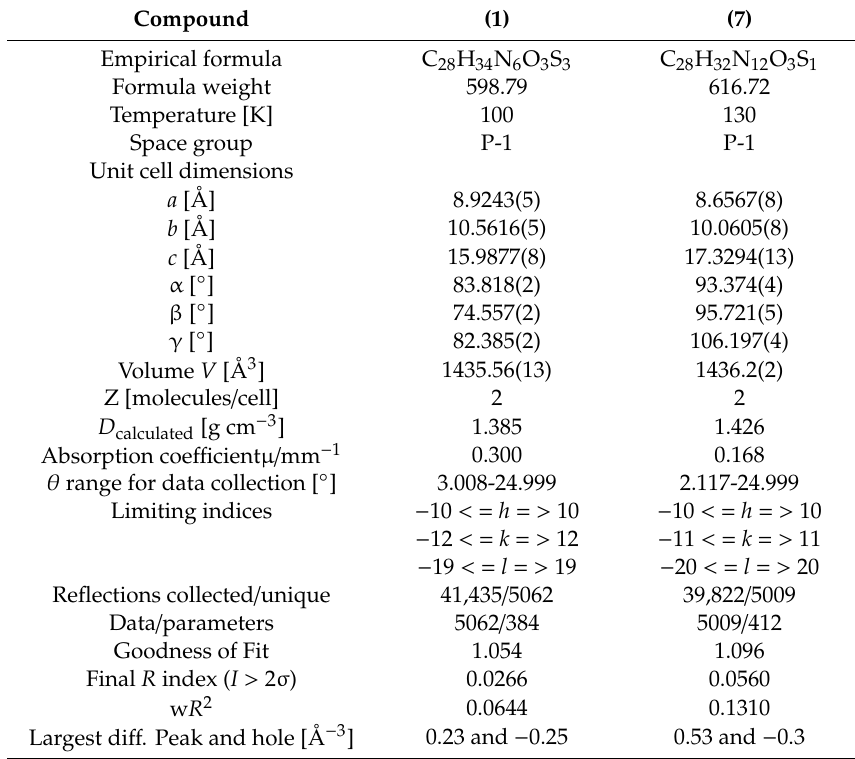
Table 2. Crystal data and structure refinement for 3-(4-methoxyphenyl)-1,1-bis{2-[3-(4-methoxyphenyl) thioureido]ethyl}thiourea( 1 )and3-(4-methoxyphenyl)-1,1-bis(2-{[1-(4-methoxyphenyl)-1H-tetrazol-5-yl] amino}ethyl)thiourea ( 7